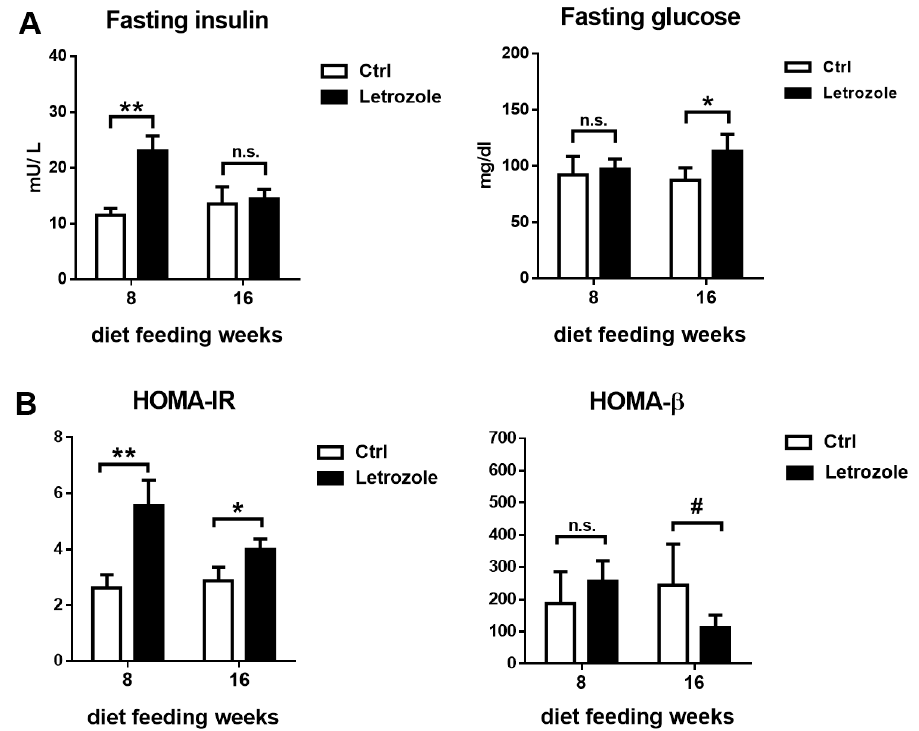
Figure 7. Comparing levels in fasting insulin, fasting glucose ( A ), HOMA-IR, and HOMA- β ( B ) levels from the letrozole-treated mice and the control groups at 8 and 16 weeks of oral feeding with letrozole. After 8 weeks of treatment with letrozole, the fasting plasma insulin levels were significantly higher in the letrozole-treated mice compared with the control mice. The HOMA-IR scores were significantly higher in the letrozole-treated mice after 8 and 16 weeks of treatment with letrozole. The results are expressed as the mean ± SD. # p < 0.1; * p < 0.05; ** p < 0.01, compared with the control mice. n.s.: not